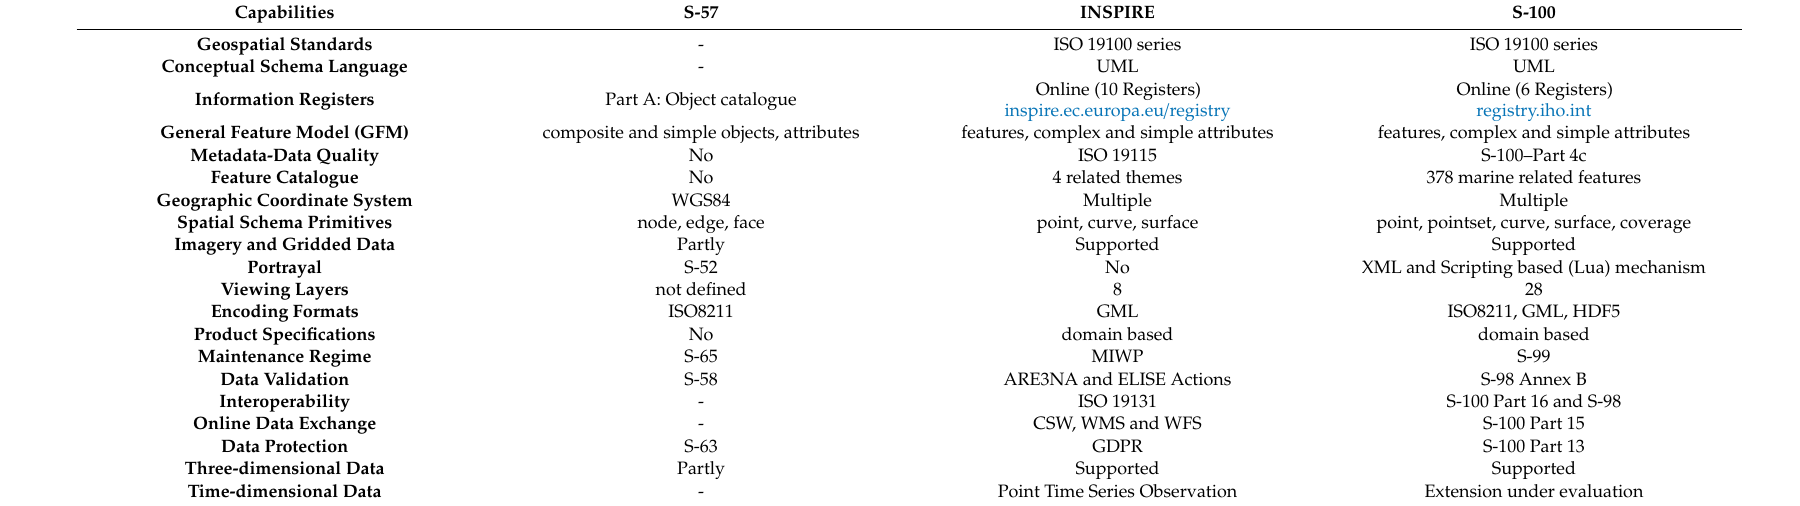
Table 3. Marine data model standards capabilities